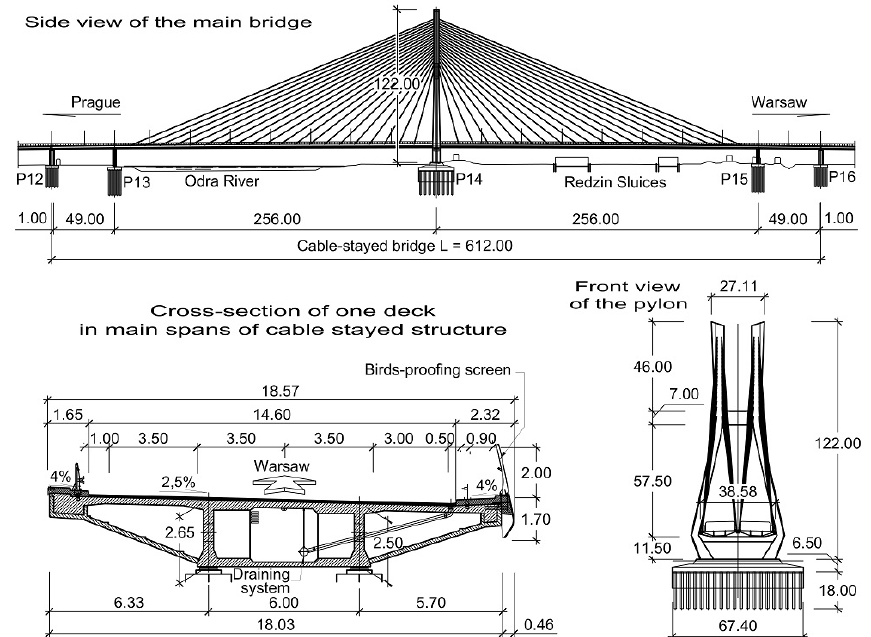
Figure 2. Main properties of the R ę dzi ń ski Bridge [7].